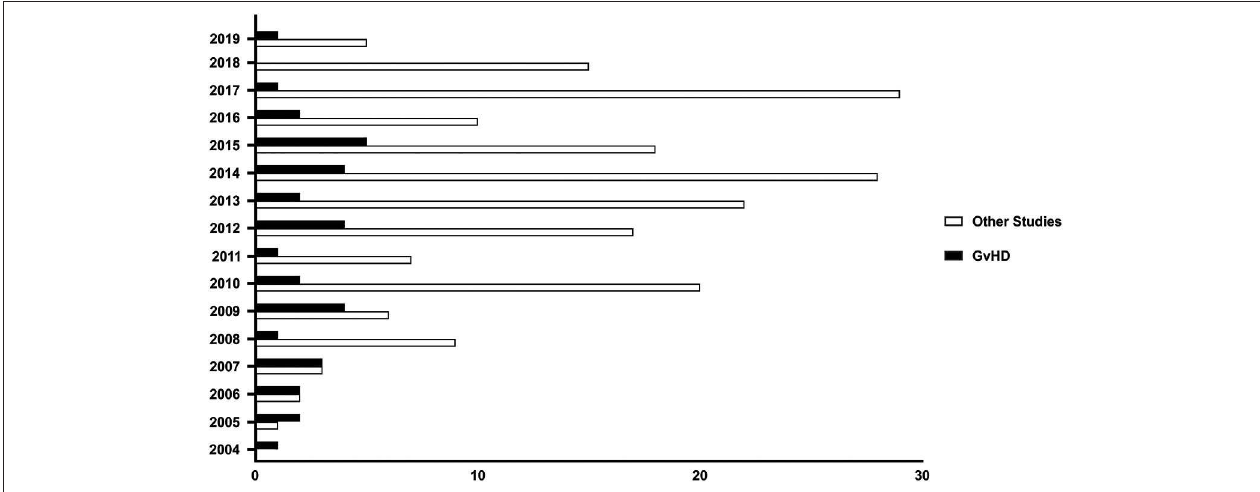
FIGURE 1 | MSCs as therapeutic agents in immune-mediated diseases. Number of Clinical trials registered at the U.S. NIH database registry (ClinicalTrials.gov) plotted according to the year of registration. Search was performed in August 2019 and included all studies whereby MSCs (Mesenchymal Stromal/Stem Cells) were used as drug for the treatment of GvHD (black bars), or other immune-mediated diseases (white bars) such as Chron’s Disease, Cystic Fibrosis, Diabetes Mellitus, engraftment of HSCT, inflammatory lung diseases (including asthma and Chronic Obstructive Pulmonary Disease), Multiple Sclerosis, neuromyelitis, Retinitis Pigmentosa, Rheumatoid Arthritis, Rheumatic arthritis, Sjogren Syndrome, solid allograft rejection, Systemic Lupus Erythematosus, Systemic Sclerosis, Ulcerative